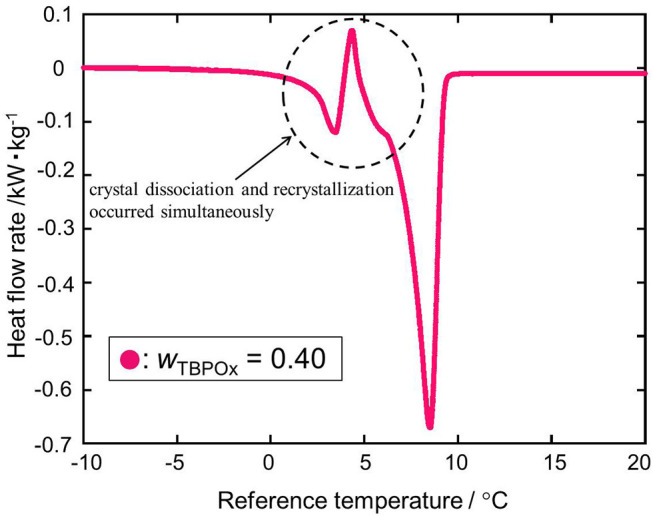
The heat flow rate at the mass fractions 0.40 with the heating rate of 0.5°C/min: red •, wTBPOx = 0.40.